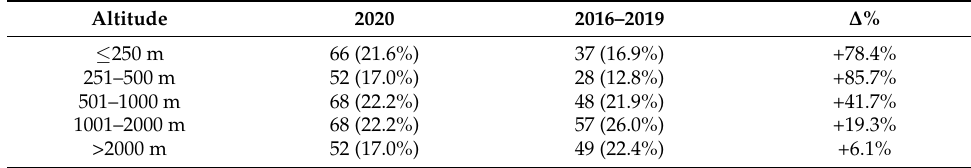
Table 5. Frequency of rescues at different altitudes.